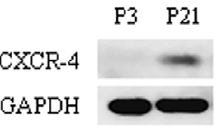
Figure 5. The expression levels of CXCR4 protein were analysed by Western blot. The band of CXCR4 protein was obviously weaker in cells at passage 3 than those of cells at 21passages in culture.